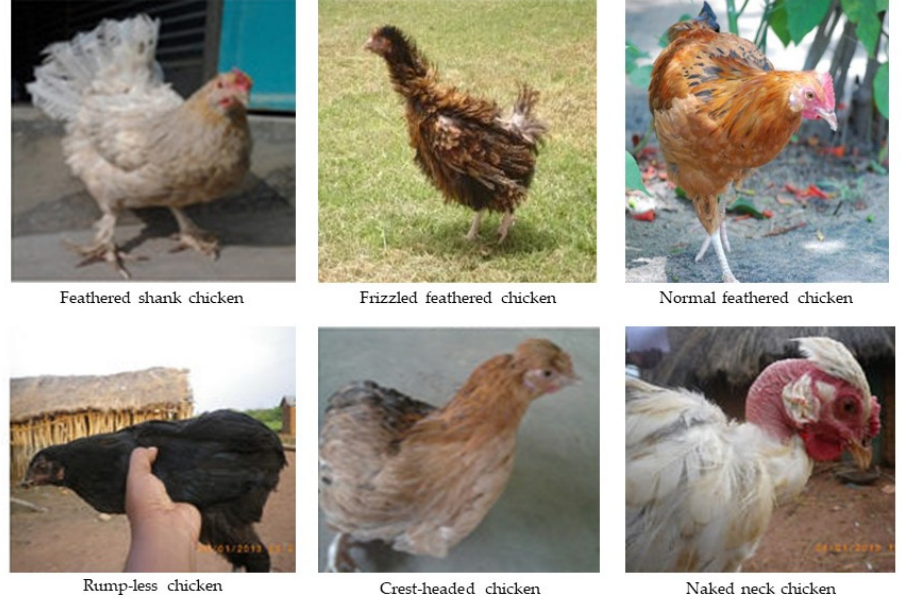
Figure 1. Unique attributes of indigenous chicken.